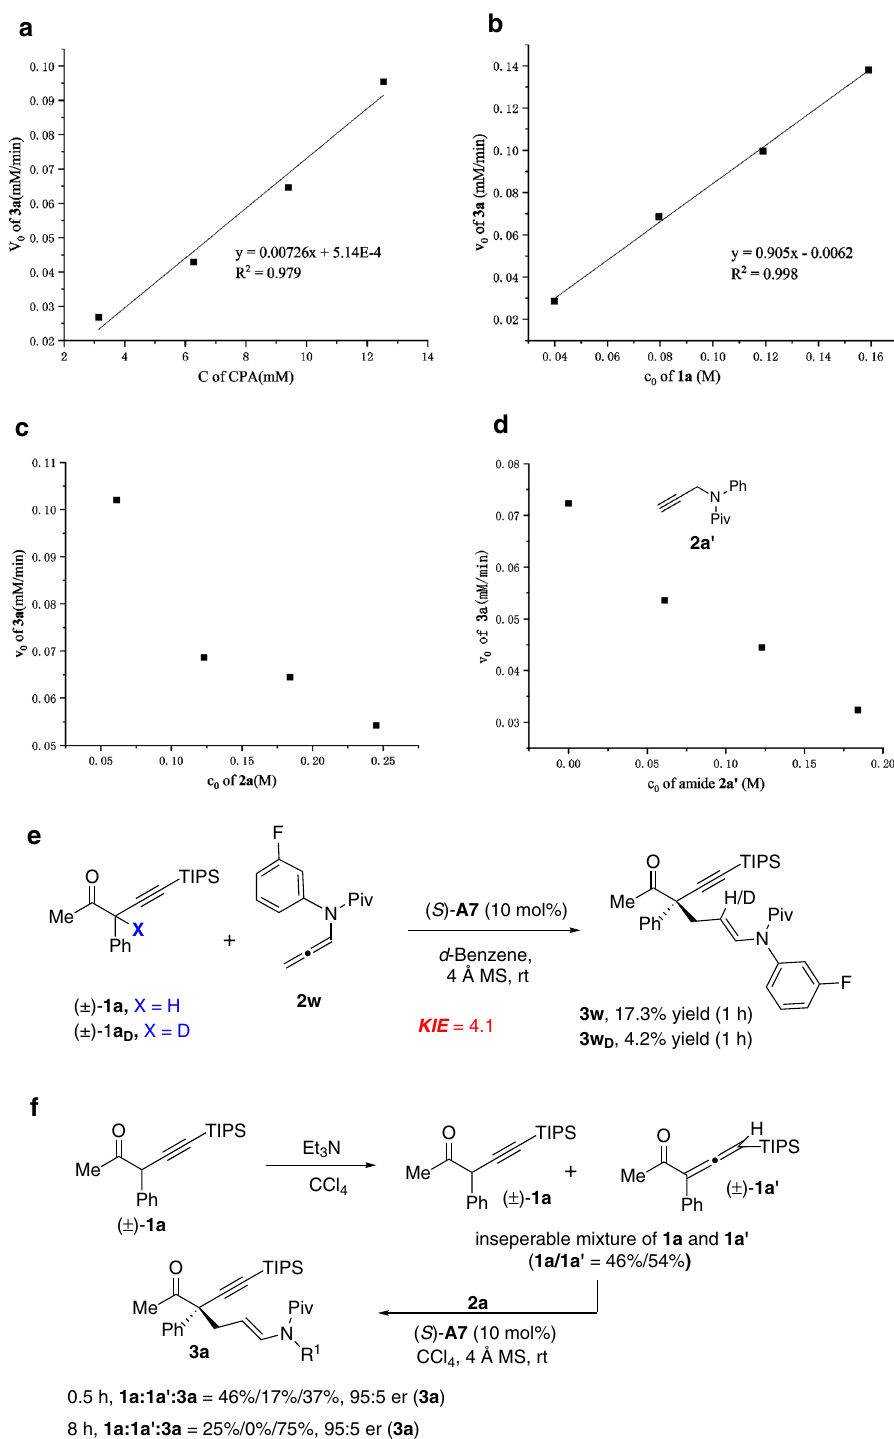
Fig. 5 Kinetic experiments. a Relationship between the initial reaction rate and concentration of the CPA catalyst A7. b Relationship between the initial reaction rate and concentration of ketone 1a. c Relationship between the initial reaction rate and concentration of the allenamide 2a. d Relationship between the initial reaction rate and concentration of the amide additive 2a ’ . e KIE experiment of the α -H of ketone 1a. f Isomerization of 1a into allenyl ketone 1a ’ and its reaction with allenamide 2a under the standard